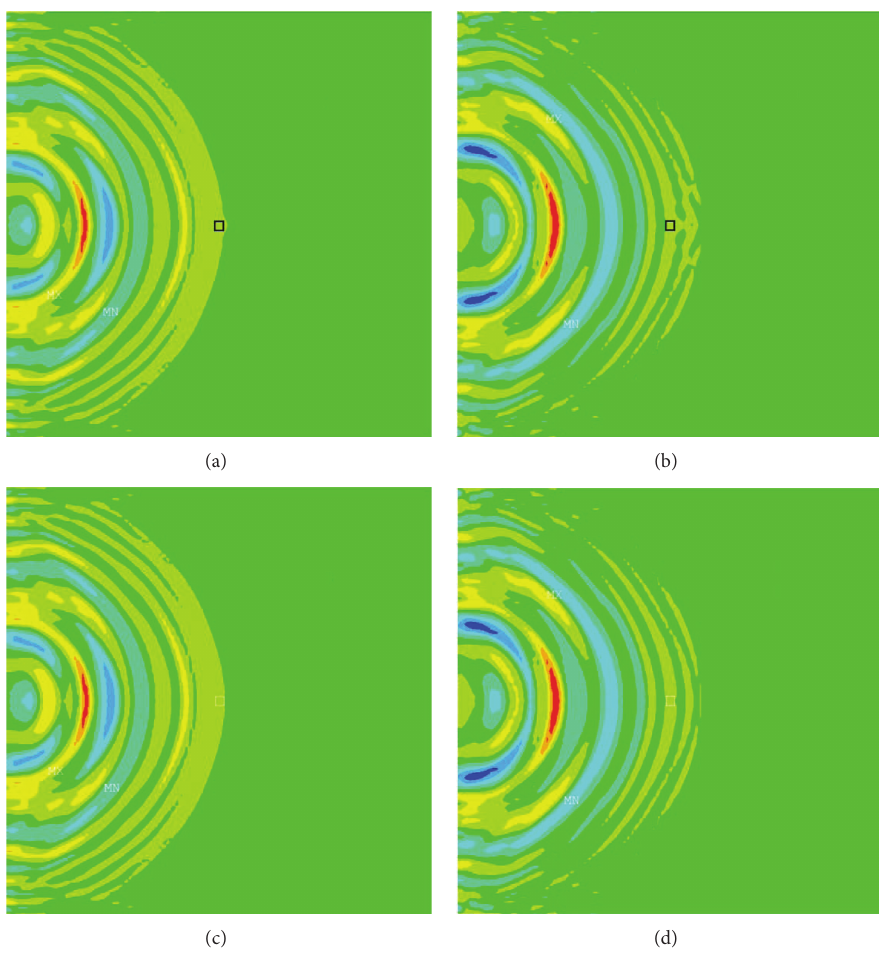
Figure 3: Illustration of shear wave front propagation at the instant (a) when the front reached the defect (black square) and (b) when it passed the defect. (c) and (d) showed the shear wave propagation in the normal cartilage at the two instants, respectively.